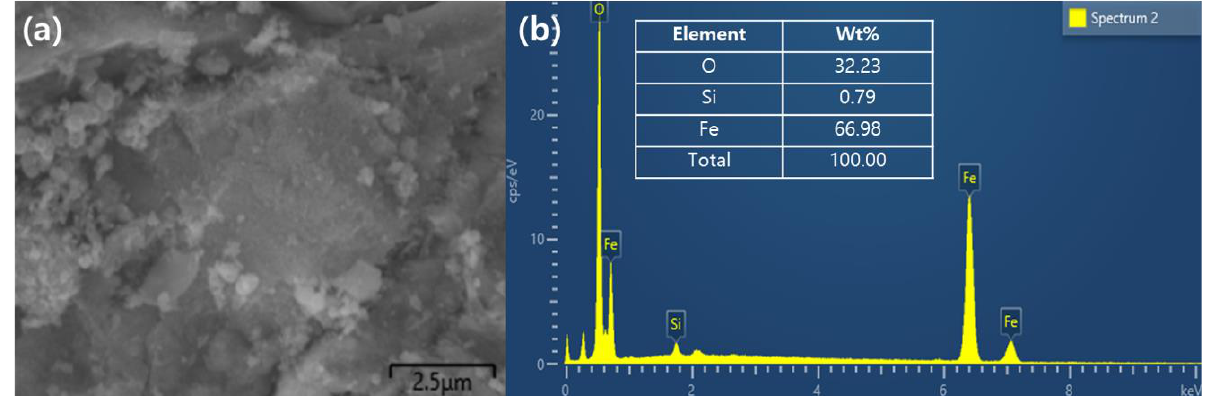
Figure 2. ( a ) Scanning electron microscope image and ( b ) energy dispersive X-ray spectrometer result of the prepared hand-warmer waste catalyst.